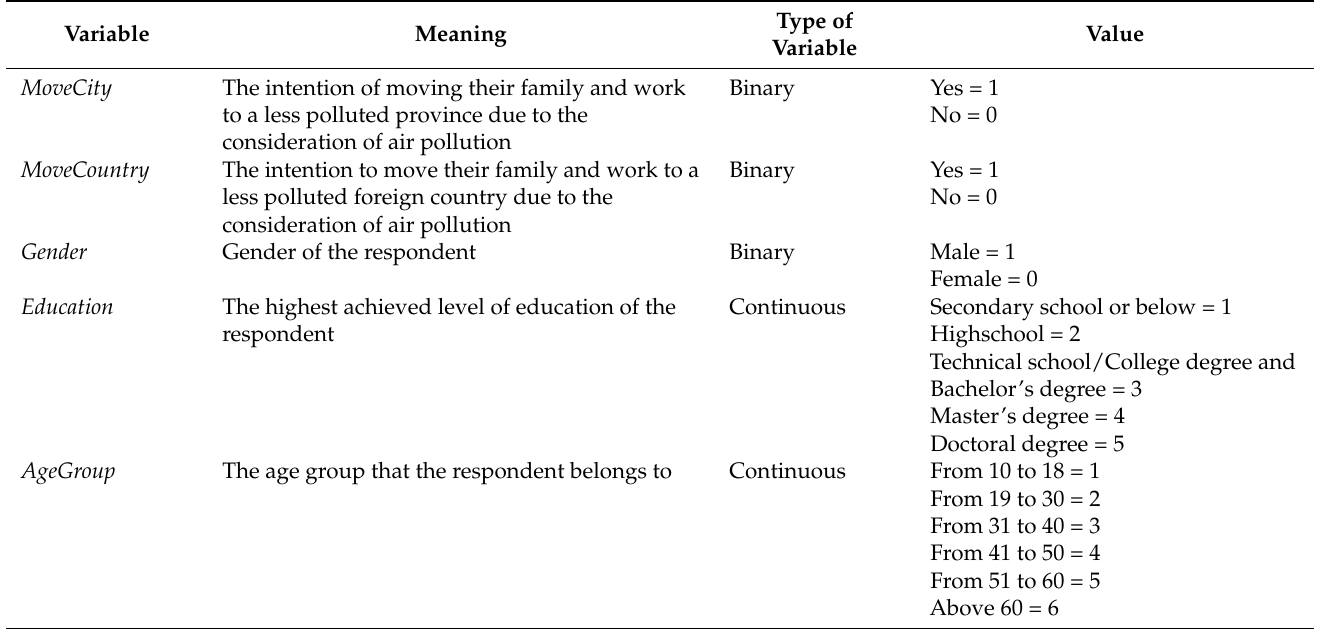
Table 1. Variable